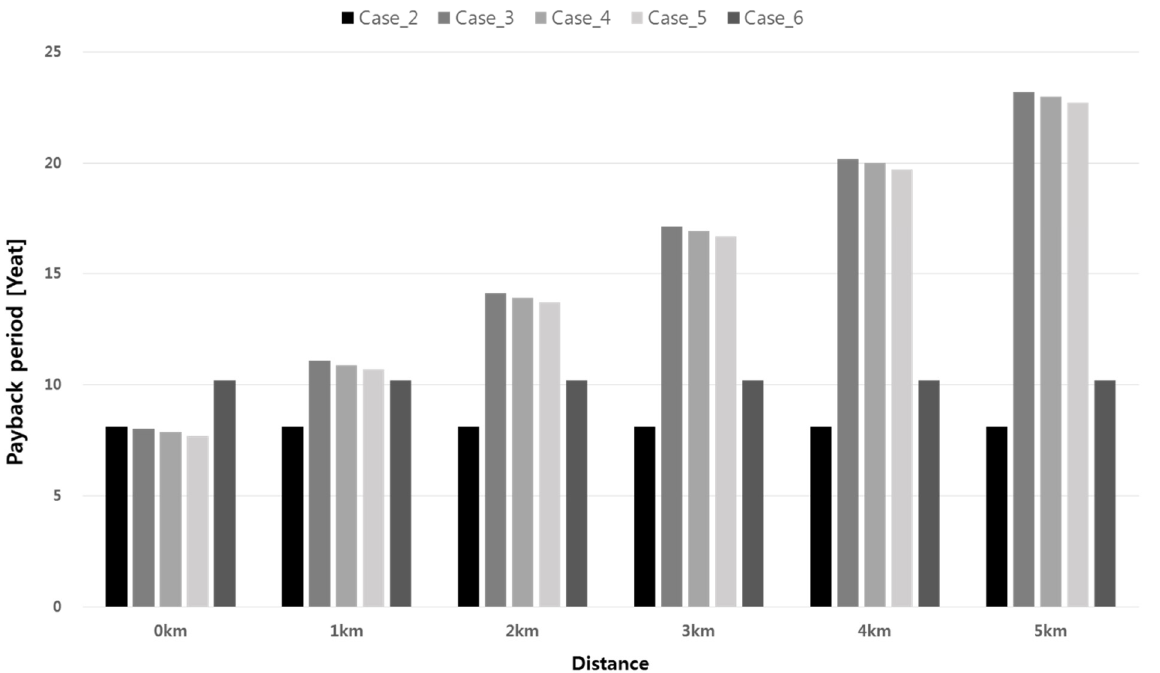
Figure 9. Payback period according to distance